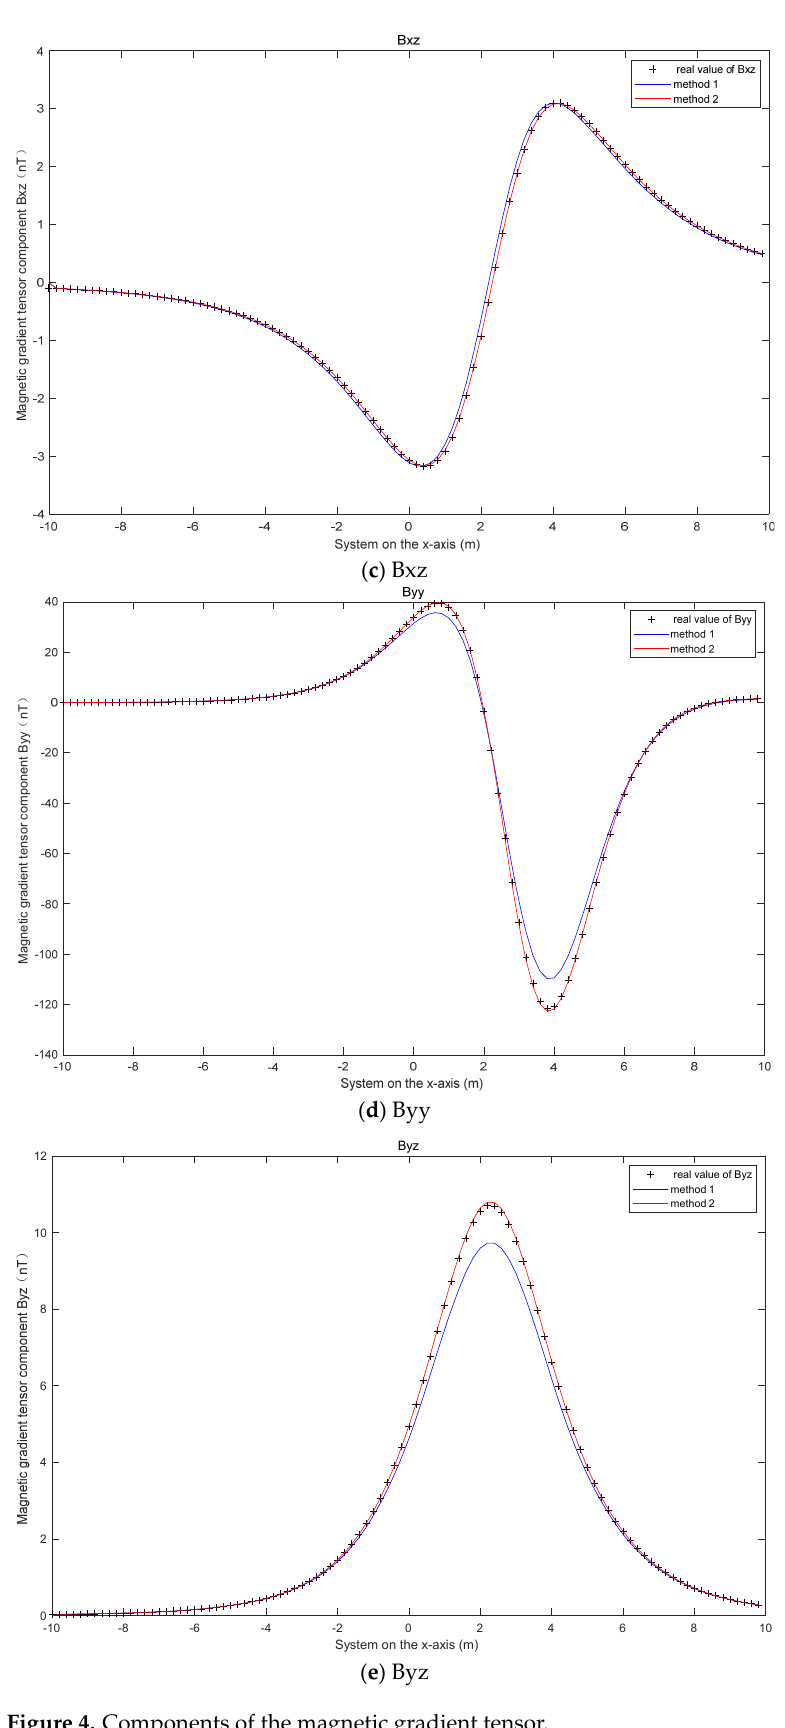
Figure 4. Components of the magnetic gradient tensor. The principal formula of the forward difference method is shown in Equation (17). For contrast, the main formula is illustrated in Equation (18).